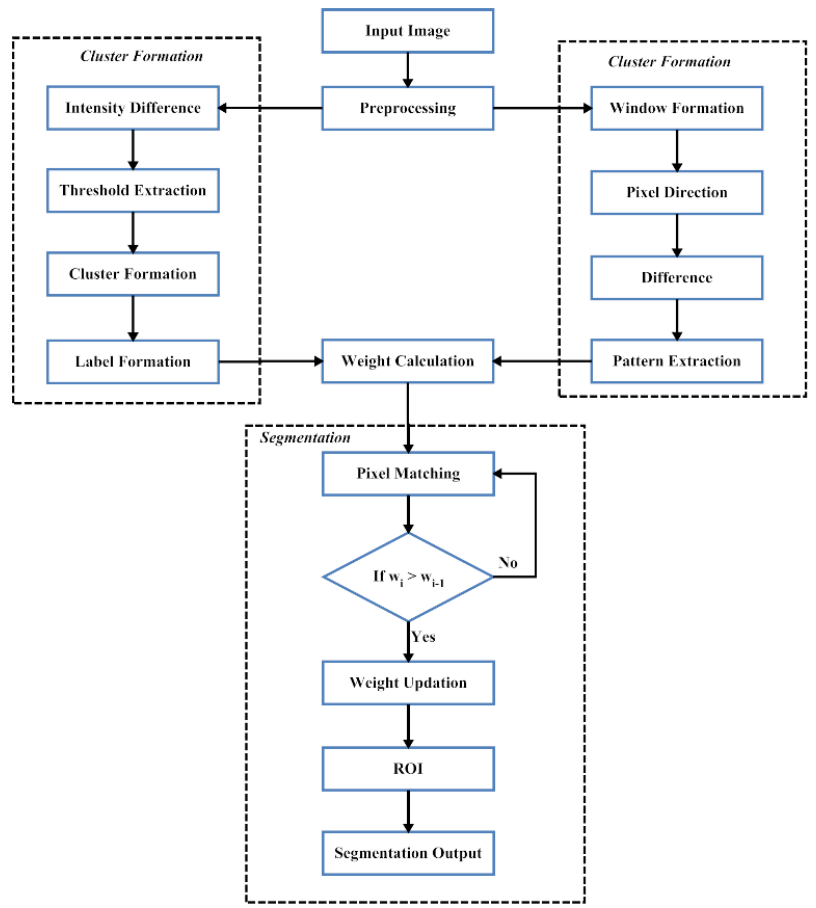
Fig. 2. Overall °ow of the proposed